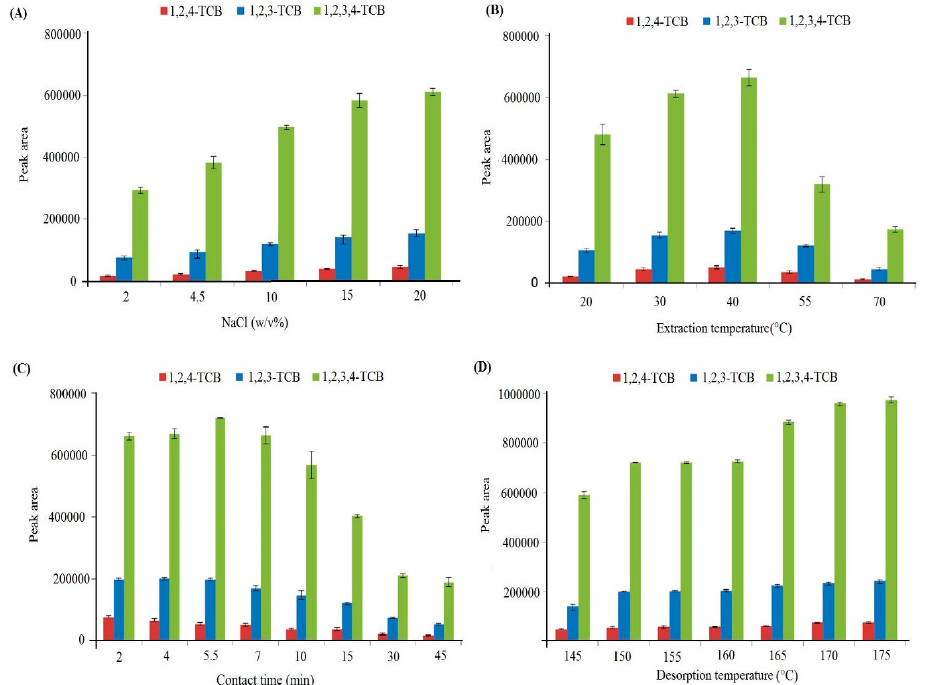
Figure 5. Influence of NaCl concentration ( A ), extraction temperature ( B ), extraction time ( C ), and desorption temperature ( D ) on the HS-SPME performance.